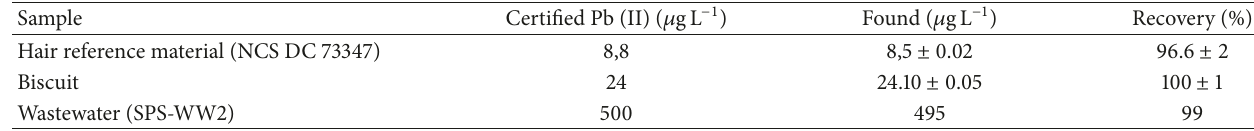
Table 3: Determination of Pb (II) ions in human hair and biscuit samples.